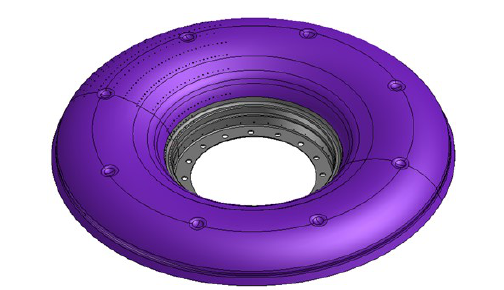
Figure 3. Schematic diagram of flame cylinder.